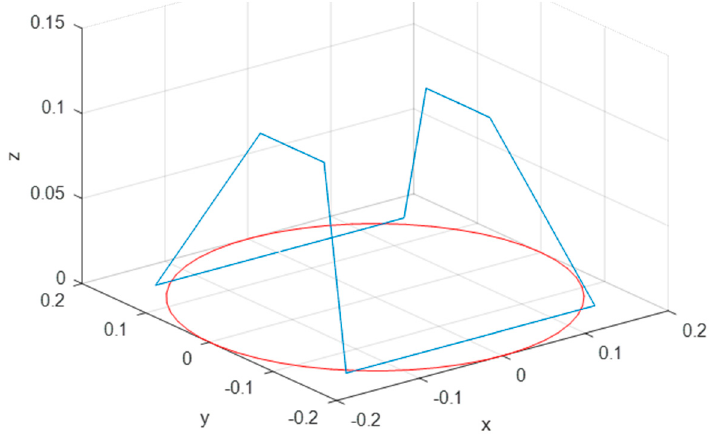
Figure 5. WPT system with primary single coil of circular shape ( red ) and three-dimensional (3D) secondary coil ( blue ).